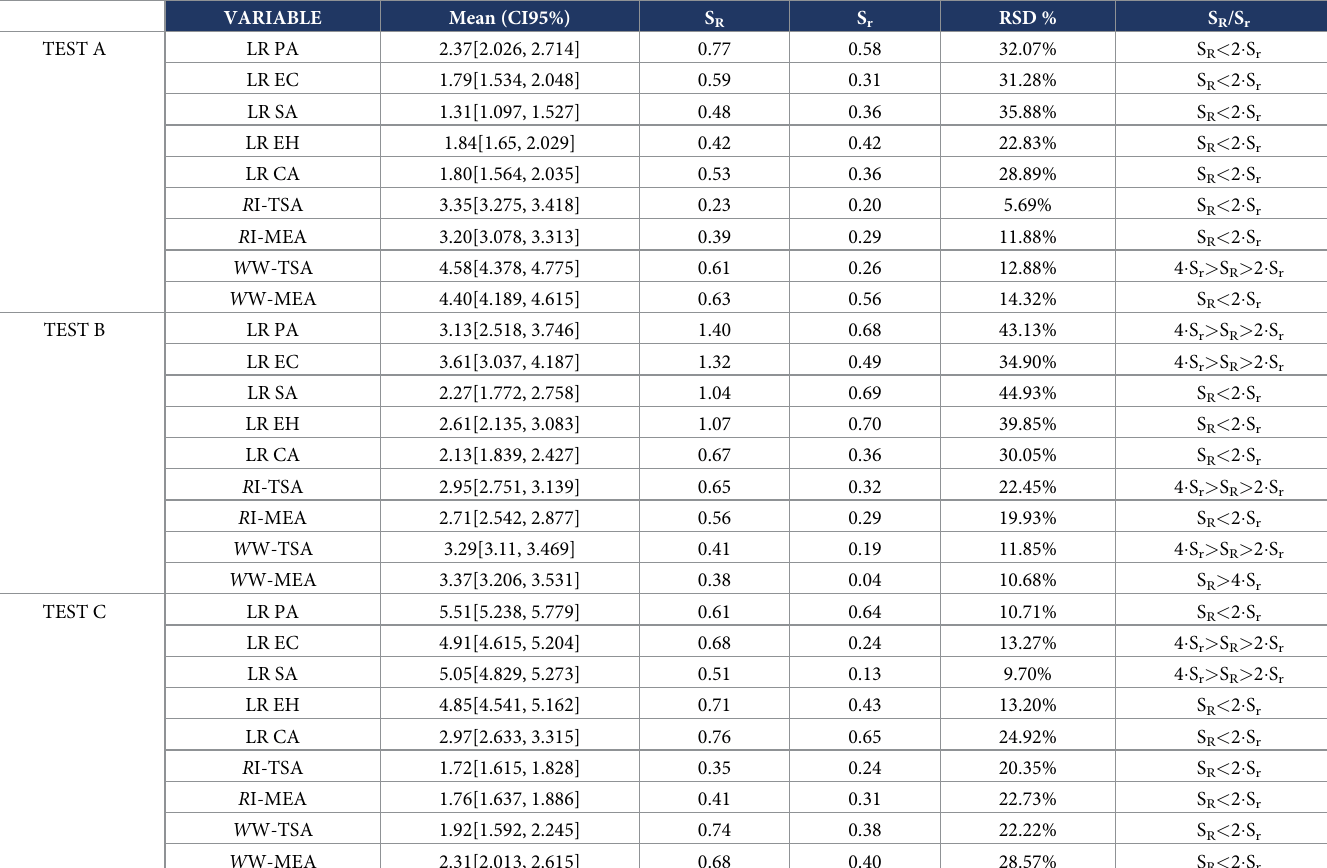
Table 1. Precision statistics for testing per prEN 17658 in the main wash